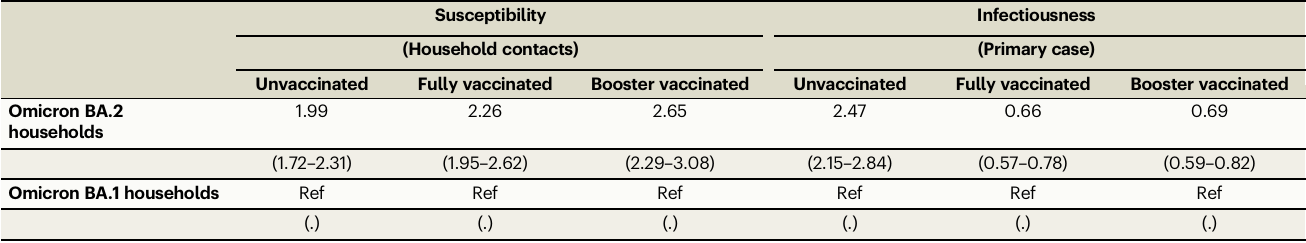
Table 3 | Relative effect of Omicron VOC BA.2 vs.